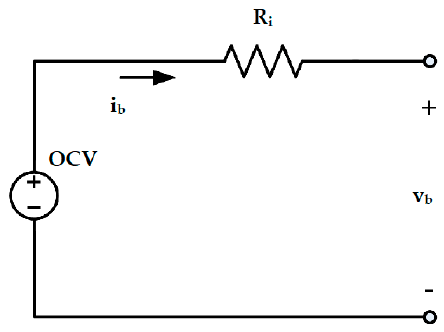
Figure 6. Battery cell equivalent circuit.